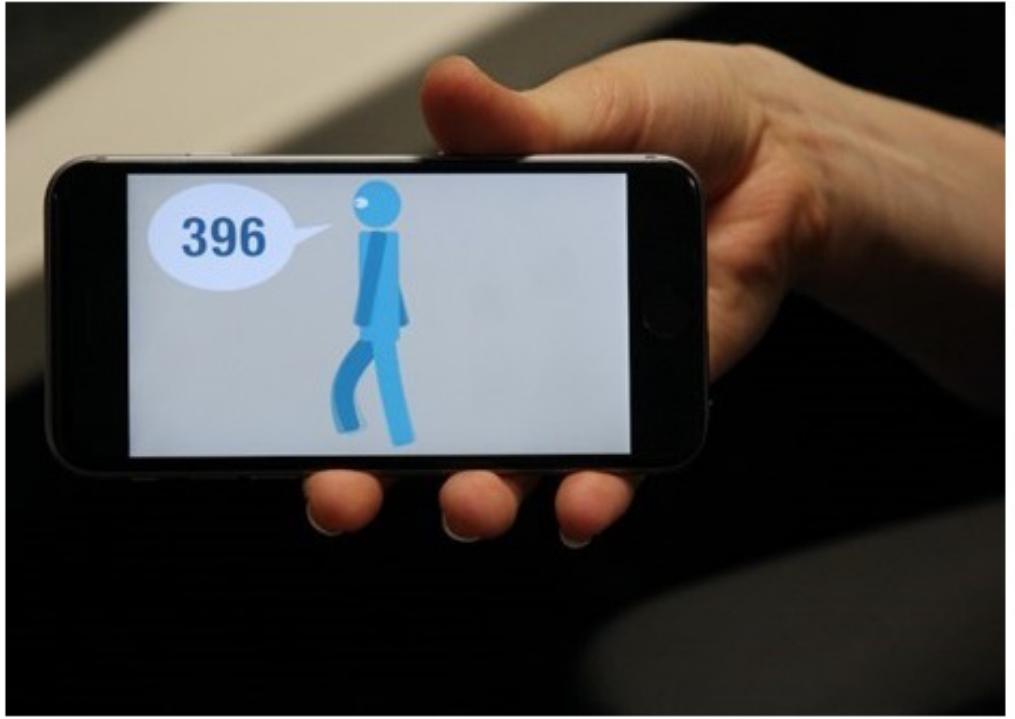
Figure 1. Screenshot of the animated instruction for dual-task walking. The app provides text and animated instructions prior to the assessment, followed by voice instructions during the assessment, to enable gait analysis from data acquired while the user walks with their phone placed in the pocket of their pants or shorts. Gait is assessed while individuals walk normally, and again while they walk and simultaneously perform a serial-subtraction cognitive dual